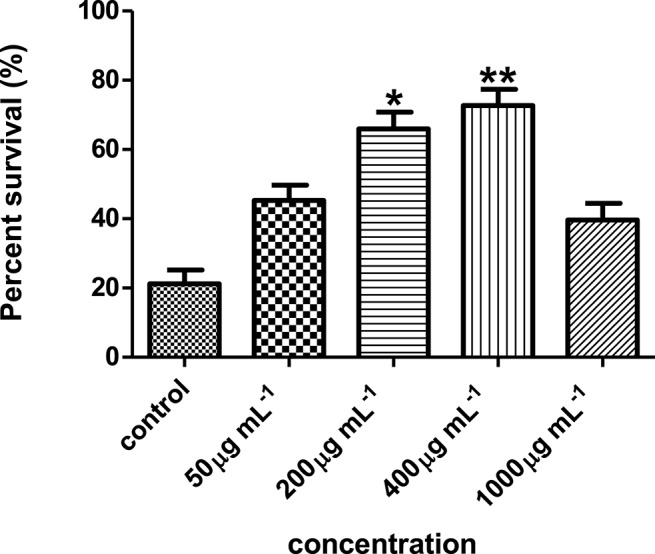
Streptomyces sp. CCB-PSK207 hexane partition promotes survivability of PA14-infected worms in a dose dependent manner. Concentration of 400 μg mL−1showed the highest percent survival of the worms compared to the untreated control. *(p<0.05) and **(p< 0.01) denotes statistically significance in Dunnett's test in comparison to the untreated control. Data were representative mean ± SD of three independent screenings at 96 h' time point.